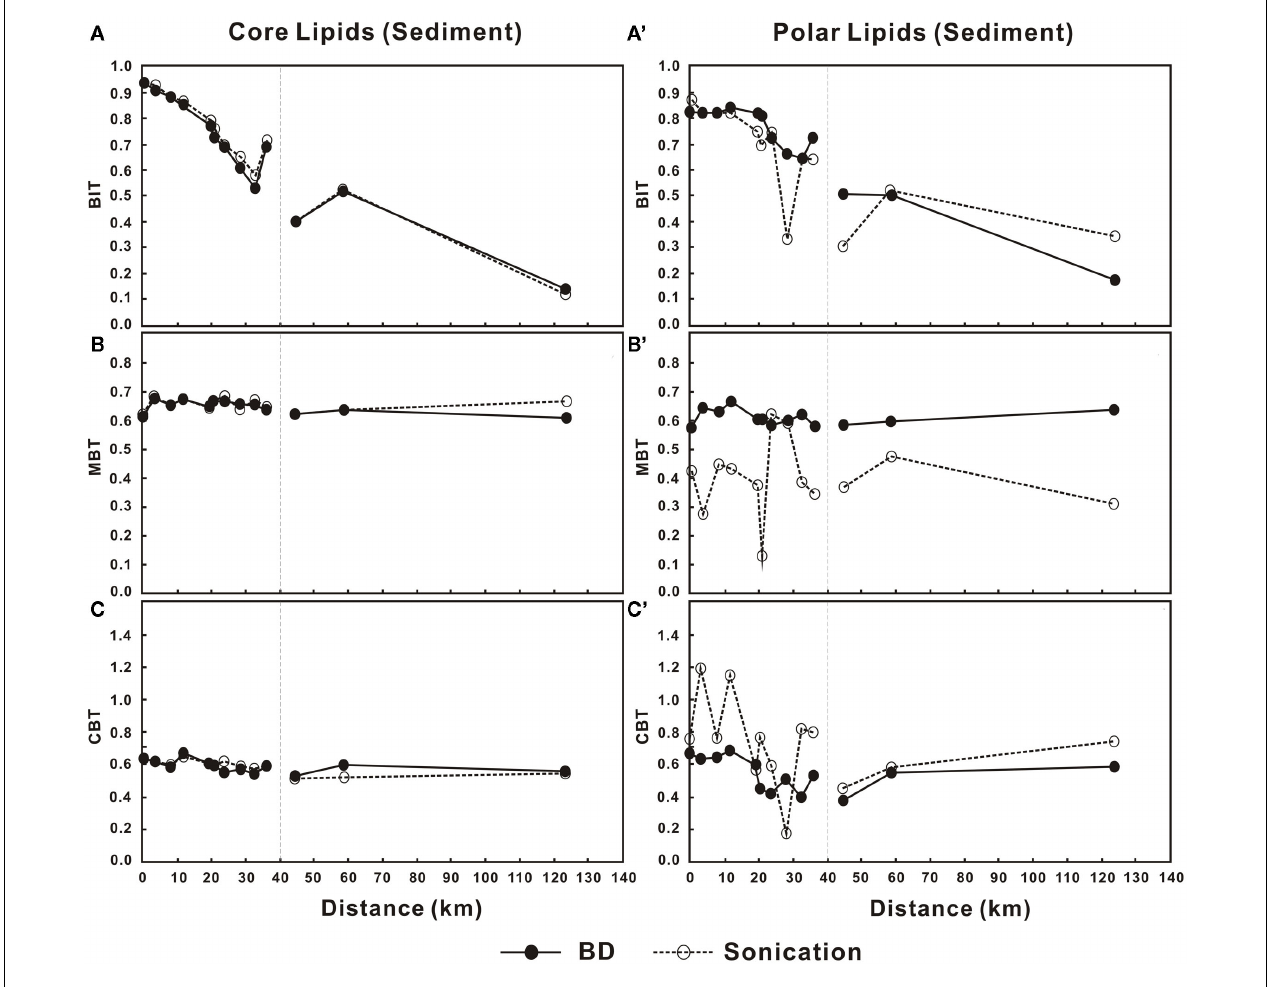
FIGURE 6 | Changes in BIT, MBT, and CBT in the sediments from lower Pearl River to the estuary for C-bGDGTs (A–C) and P-bGDGTs (A (cid:2) –C (cid:2) ) for